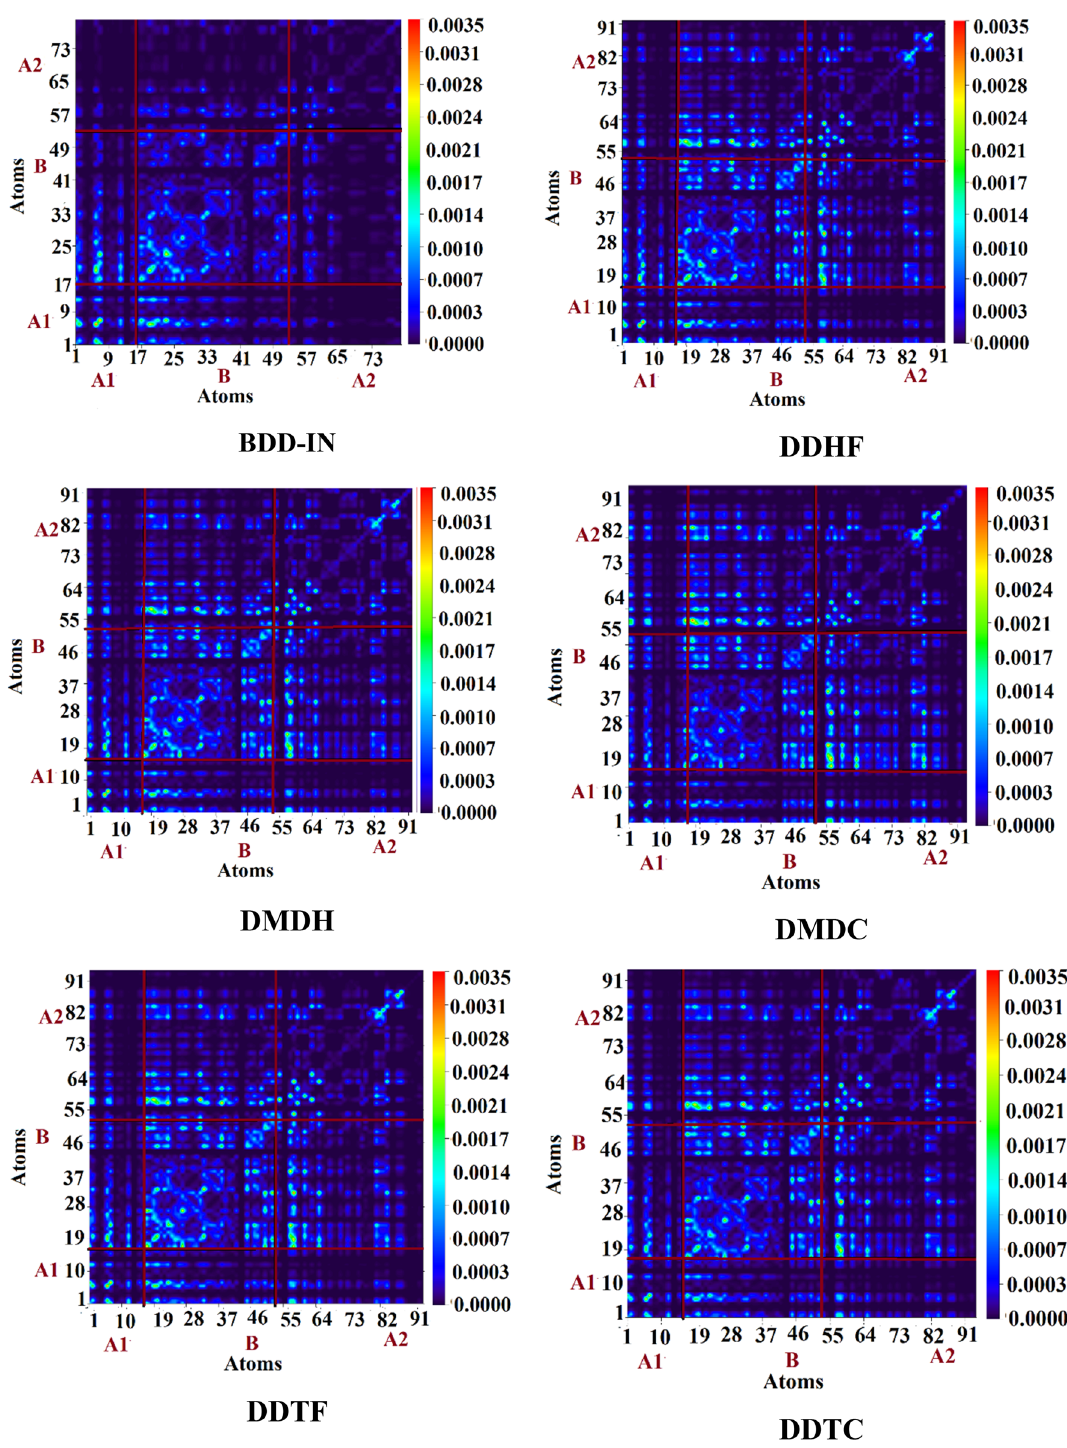
Figure 9. Graphical representation of transition density matrix (TDM) at the S1 state. The were drawn with the help of Multiwfn 3.7 software (http:// sober eva. com/ multi wfn/). All out put files of designed compounds were accomplished by Gaussian 09 version D.01 (https:// gauss ian. com/ g09ci